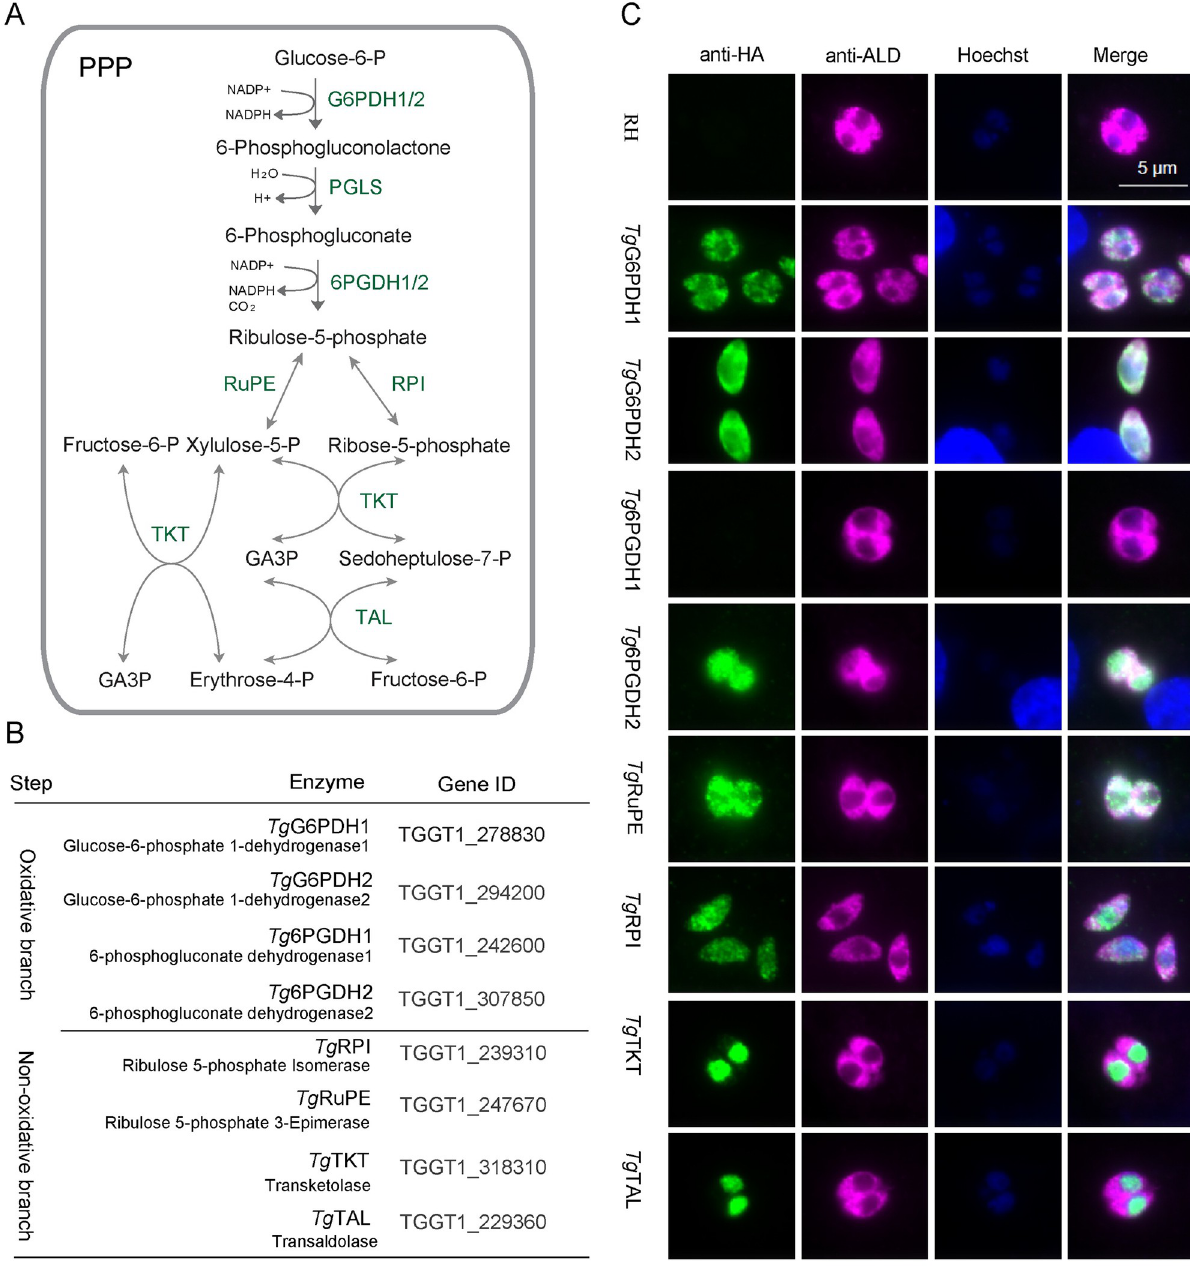
PLOS Pathogens| https://doi.org/10.1371/journal.ppat.1010864 September 19, 2022 4 /